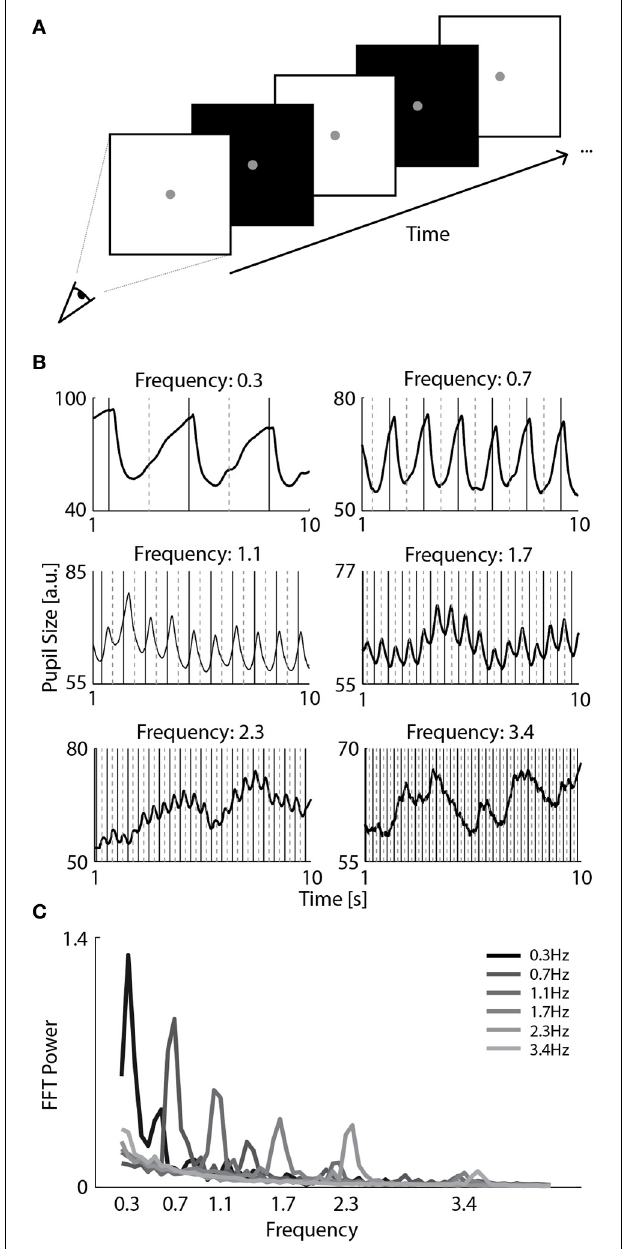
FIGURE 1 | Pupillary responses to a range of screen flicker rates. (A) Observers viewed full monitor screens that flickered at a particular frequency rate (0.3, 0.7, 1.0, 1.7, 2.3, or 3.4Hz) while their pupil size was recorded with a camera. (B) Examples of pupil size of a selected observer as a function of time in six separate trials with distinct flicker frequencies. The solid and dashed vertical lines indicate the onsets of white and black screens, respectively. (C) Average spectrum of FFT power per flicker frequency across all